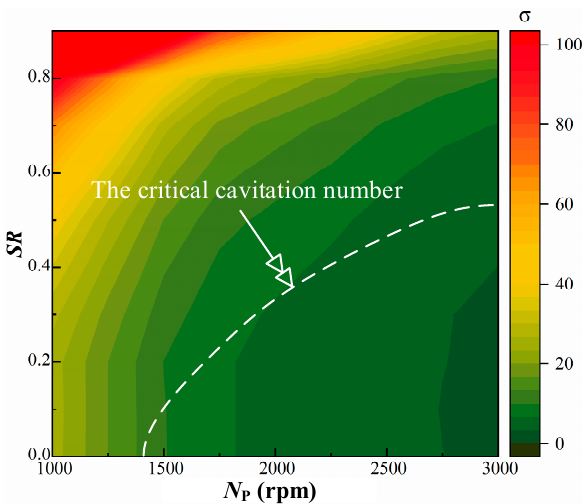
Figure 18. The cavitation number under various N P and SR.